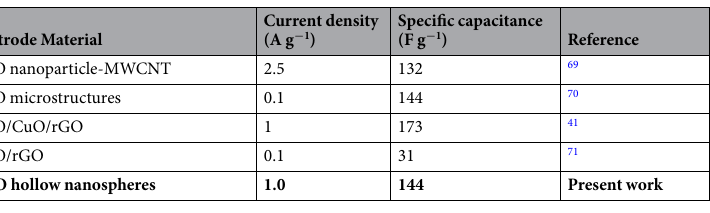
Table 1. Comparison of present electrochemical result with some recent results on Cu 2 O based electrode